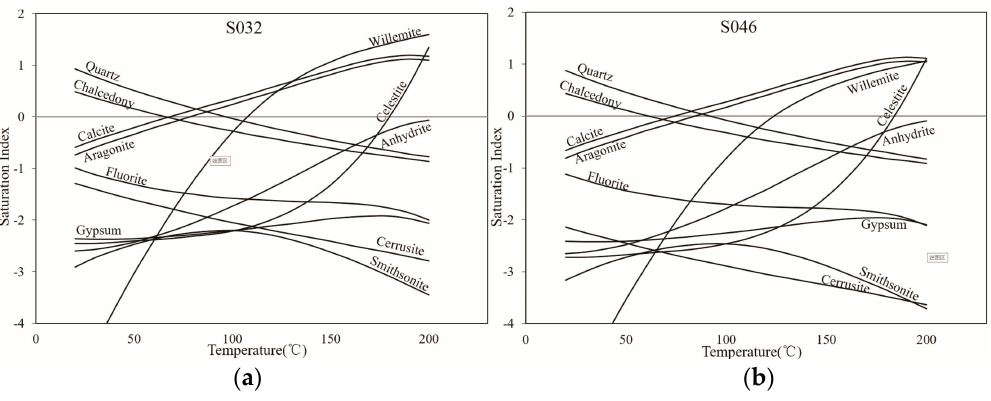
Figure 8. Mineral equilibrium diagram of the sampling points ( a ) S032 and ( b ) S046 as representatives of thermal water.